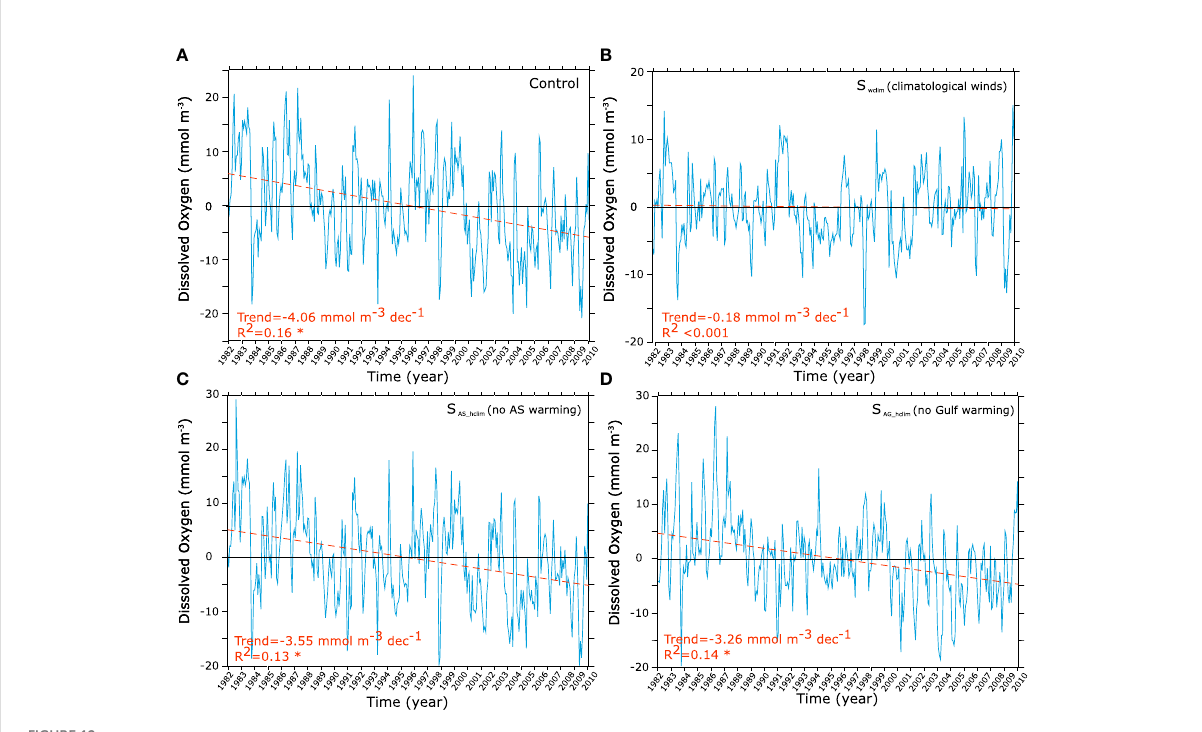
FIGURE 12 O 2 trends in the control and under different atmospheric forcing scenarios. O 2 interannual anomalies and trends in the deep Gulf (bathymetry > 40 m) as simulated in the control (A) , in absence of wind changes (i.e., S wclim ) (B) , in absence of warming over the Arabian Sea (i.e., S AS_hclim ) (C) and in absence of Gulf warming (i.e., S AG_hclim ) (D)